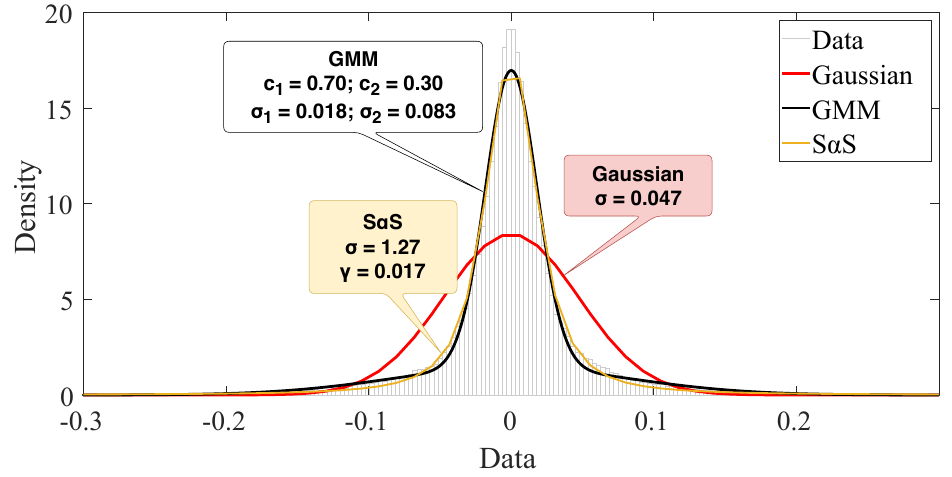
Figure 13. Illustration of PDF fitting for all models (data from the outdoor scenario in a time window with severe